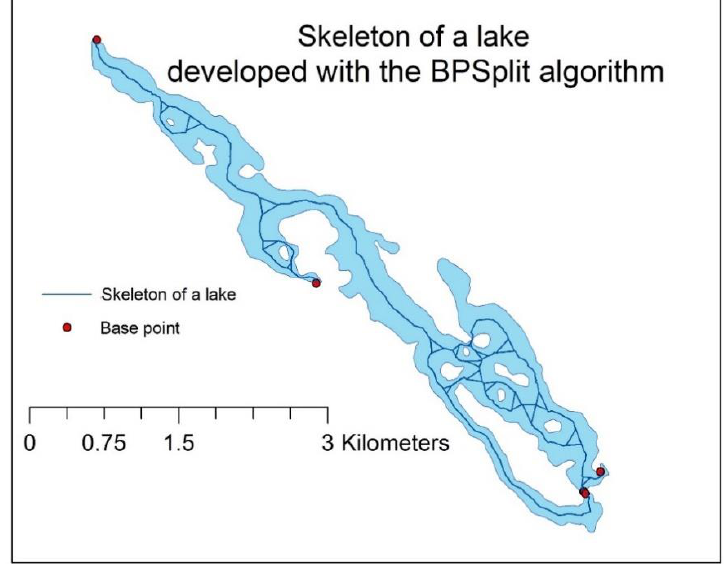
Figure 24. Skeleton of a lake with numerous islands developed with the BPSplit algorithm based on the adopted set of base points.